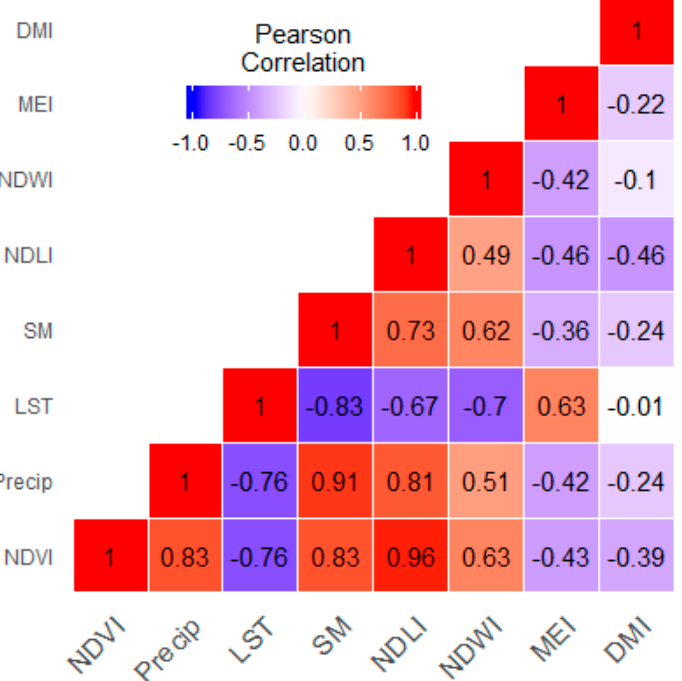
Figure 9. The heat map of Pearson correlation coefficients for NDVI, Precipitation, LST, soil moisture, NDLI, NDWI, MEI, and DMI.